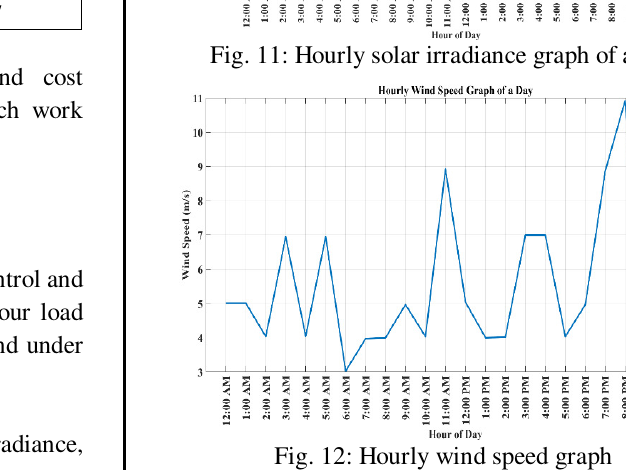
Fig. 12: Hourly wind speed graph